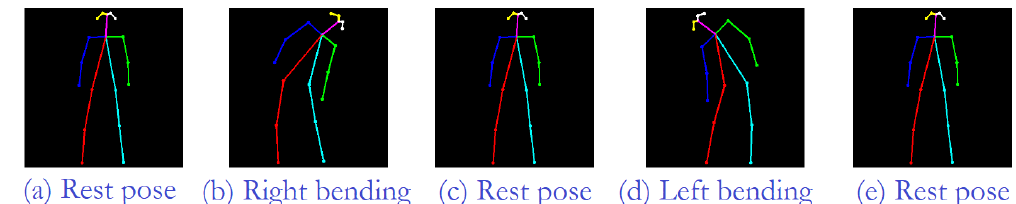
Figure 3. Five-pose sequence showing the exercise sideways bend in terms of limb positions. So, the first human pose corresponds to the rest pose. The next pose shows the pose when the right arm has been slid down towards the right foot. The rest pose is the following step. Then, the left arm has been slid down towards the left foot. The finally pose corresponds to the rest pose.